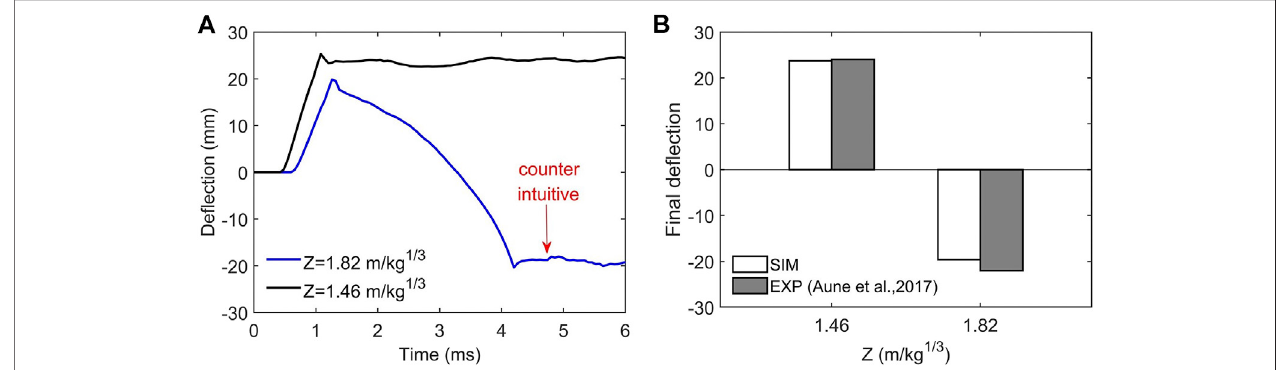
FIGURE 3 | Dynamic responses of a monolithic metal plate. (A) The de fl ection time histories at the plate center. (B) The fi nal de fl ections under two impulsive loads de fi ned in terms of the scaled distance Z .